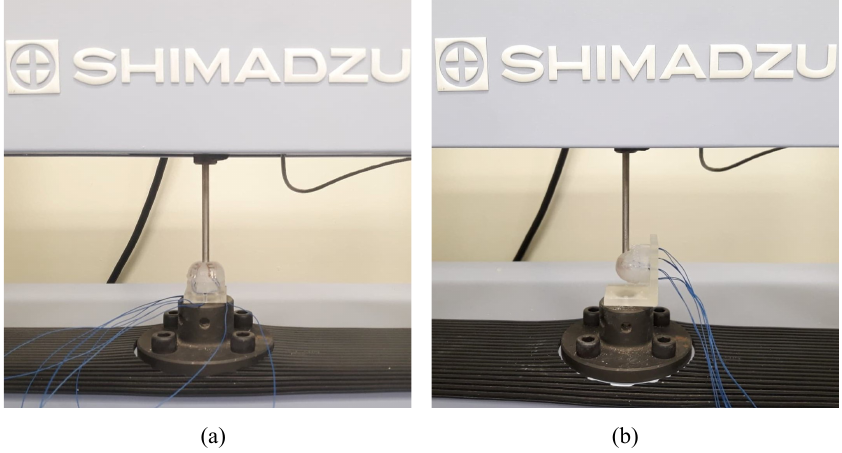
Figure 3. Force calibration setup for the multi-directional tactile sensor: ( a ) force along z-axis and ( b ) force exerted from the different directions of xy-plane.